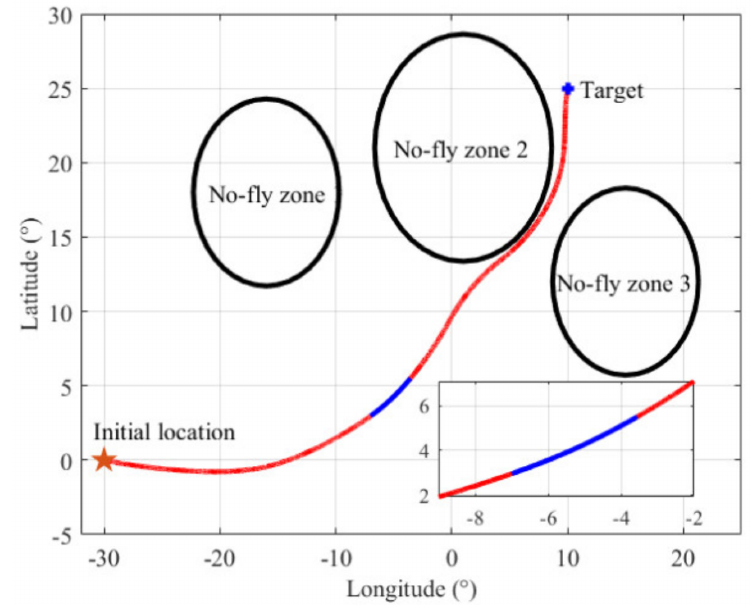
Figure 3. Ground track of the